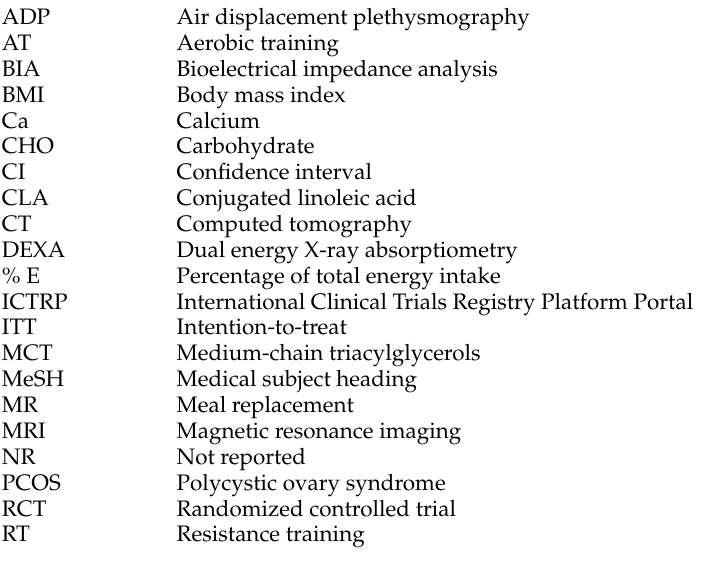
Table S1: Baseline protein and calcium intakes stratified by intervention group as reported by study participants; Table S2: Daily nutrient intakes from intervention diets as reported by study participants; Table S3: Quality appraisal of included studies; Figure S1: Mean body weight difference (kg) between high dairy and control groups by difference in daily serves of dairy food intake for trials using whole dairy foods ( n = 15). The size of the circle is proportional to the inverse of the within-study variance of effect size . ; Figure S2: Funnel plot for A. Body weight (kg); B. Body fat mass (kg); C. Body lean mass (kg); SE, standard error; MD, mean weighted difference between high dairy and control